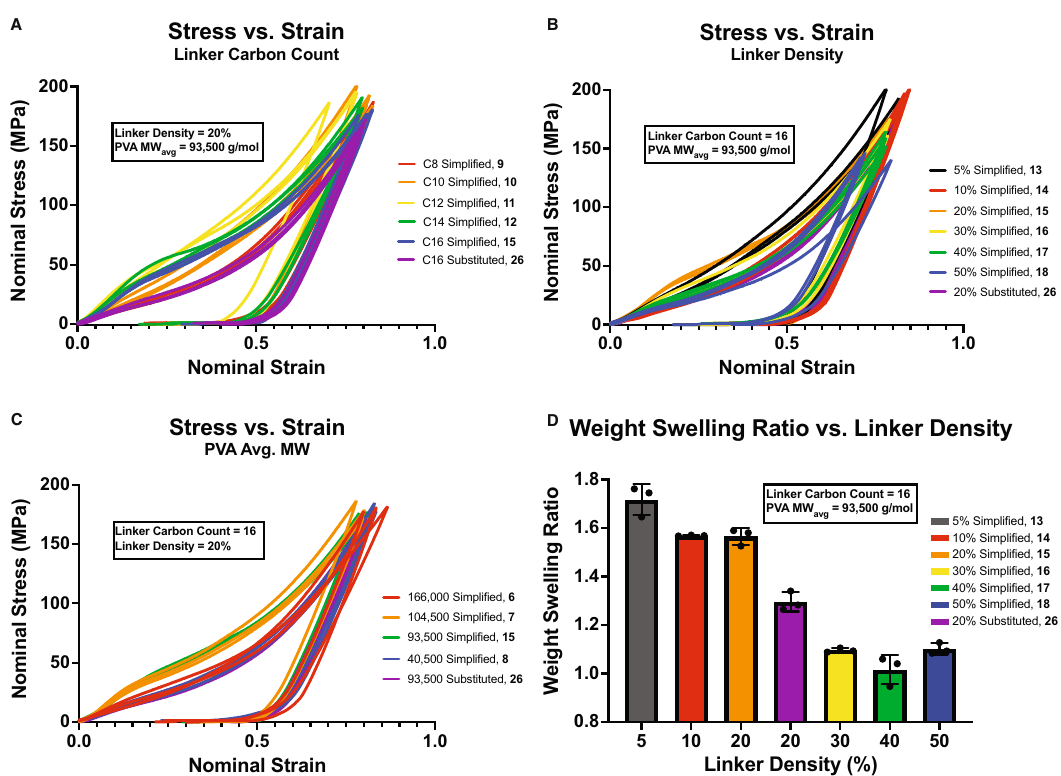
Fig. 4 Comparison of representative compressive stress-strain curves of synthetic sporopollenin analogues. A crosslinker length, B crosslinker density, and C PVA average molecular weight and D relationship between weight swelling ratio and crosslinker density ( n = 3, error bars = standard